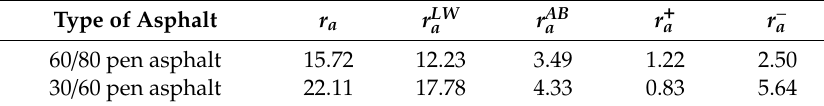
Table 9. Surface energy parameters of asphalt.